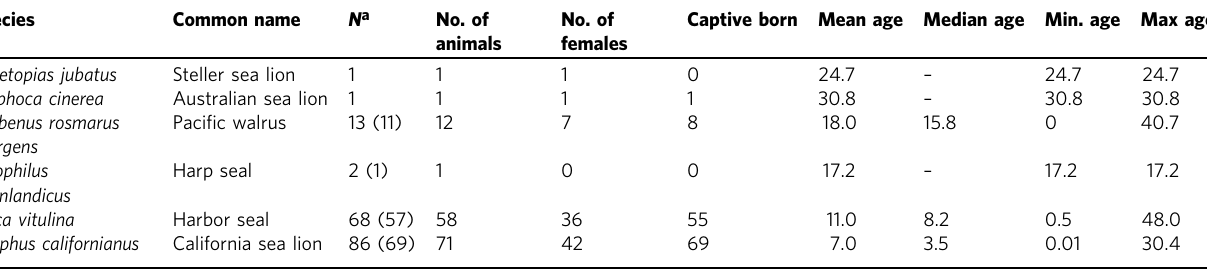
a Total number of blood and skin samples used for clock development, number of blood samples in